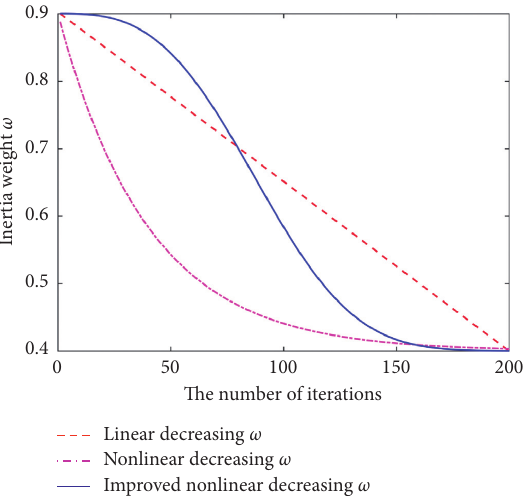
Figure 5: Comparison curve of inertia weight of three PSO algorithms.